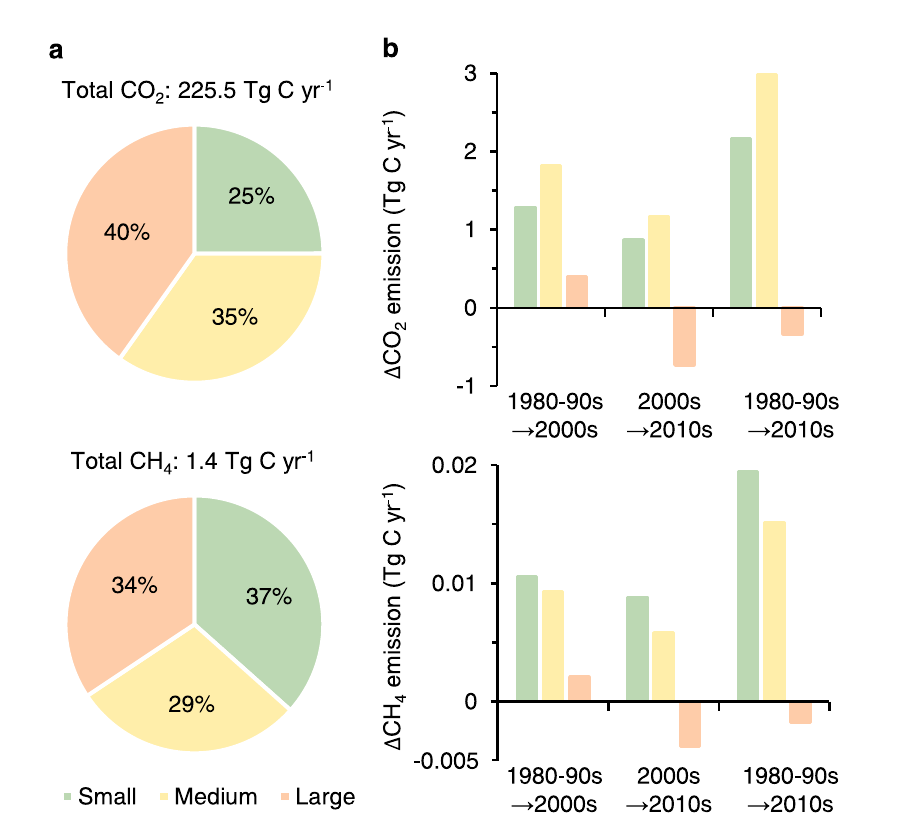
lakestolakesizevariabilitybetweendifferentperiods,estimatedastheproportion of the absolute areal changes in small lakes within a given 1°×1° grid cell (see Methods).Thegrayareasindicateregionswithinsuf fi cientsatellitecoverageinthe early